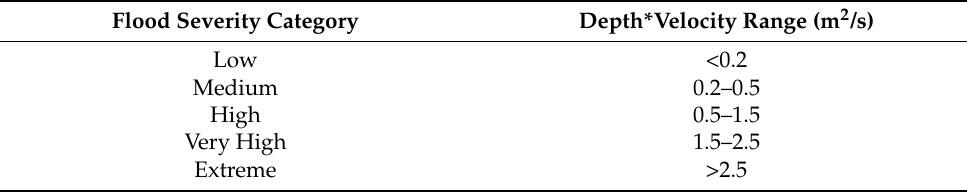
Table 5. Flood severity classes (first classification